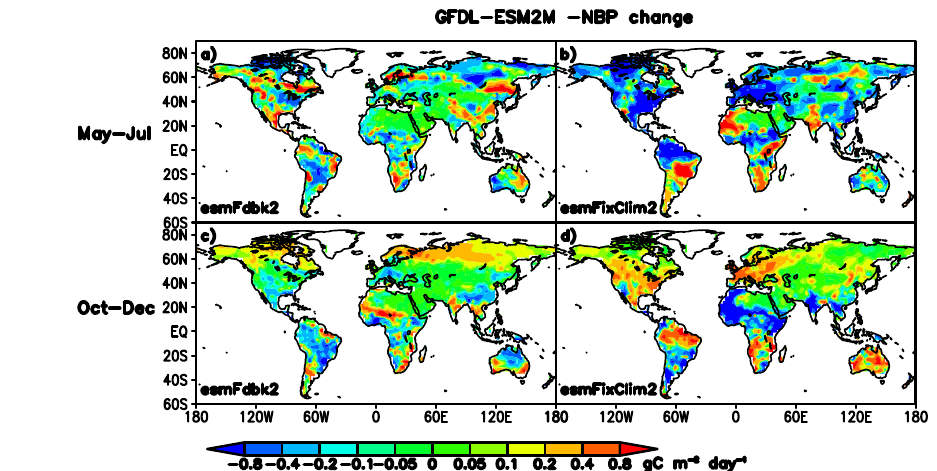
Figure 6. Spatial patterns of GFDL-ESM2M − NBP (gCm − 2 day − 1 ) changes from 2081 to 2090 and from 1961 to 1970, during mean peak growing season (May–July, first row) and dormant season (October–December, second row) for the esmFdbk2 (first column, constant CO 2 fertilization and changing climate) and esmFixClim2 (second column, constant climate and rising CO 2 ) experiments. The northern high latitude regions show mixed response to climate change during peak growing season (a) , and most of the northern temperate and boreal regions see enhanced carbon uptake under elevated CO 2 (b) . Net carbon release is increased both under climate change (c) and elevated CO 2 conditions (d) , however they have different spatial patterns.